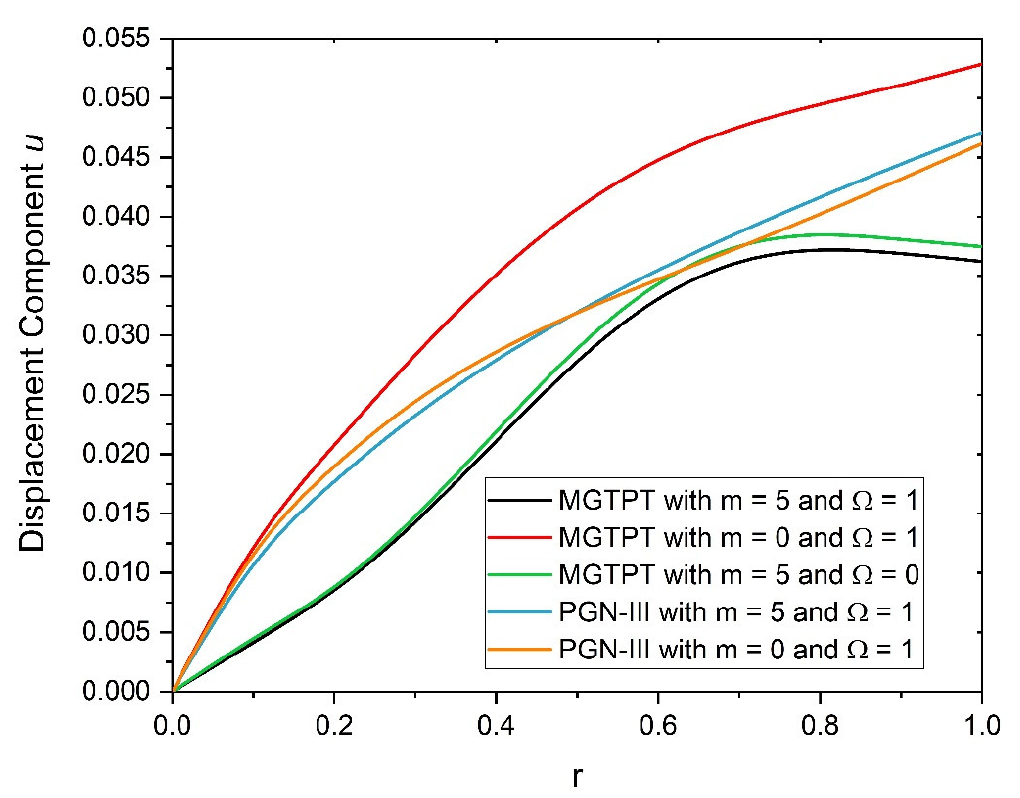
Figure 2. The radial displacement variation for various models with Hall effect and rotation.